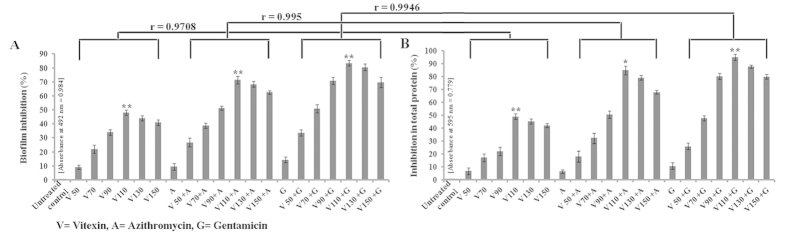
Effect of sub-MIC doses of vitexin (V), azithromycin (A) and gentamicin (G) alone and in combination of vitexin-azithromycin and vitexin-gentamicin upon percentage of biofilm inhibition (with respect to untreated control) by P. aeruginosa (A) and quantity of percentage biofilm total protein inhibition (with respect to untreated control) of P. aeruginosa (B). Each value is the average of triplicate assay where presented data is mean ± SD. Statistical analysis were done using one way ANOVA and * express P value < 0.01 and ** express P value < 0.001 (n = 3). Correlation study between experimental sets was done through Pearson’s correlation and expressed by r value.